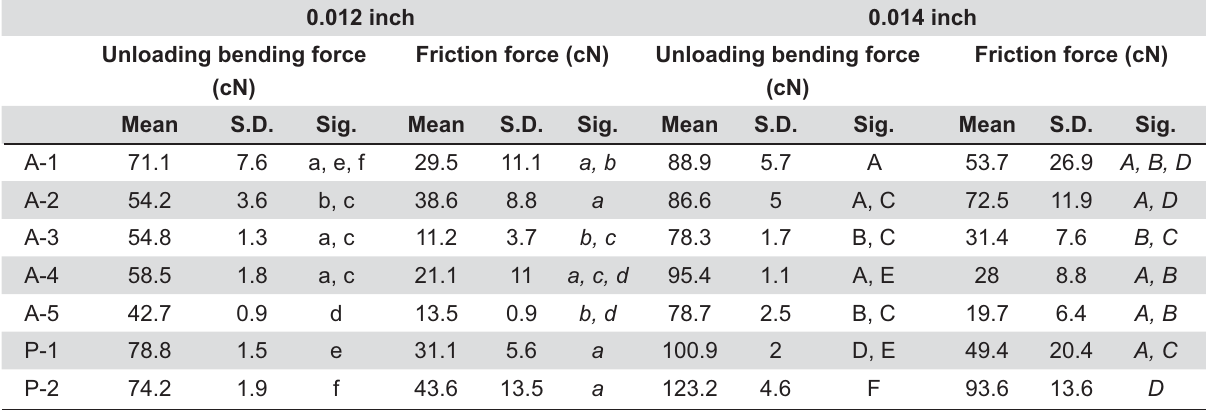
Table 2- Unloading bending and friction forces at a displacement of 1.0